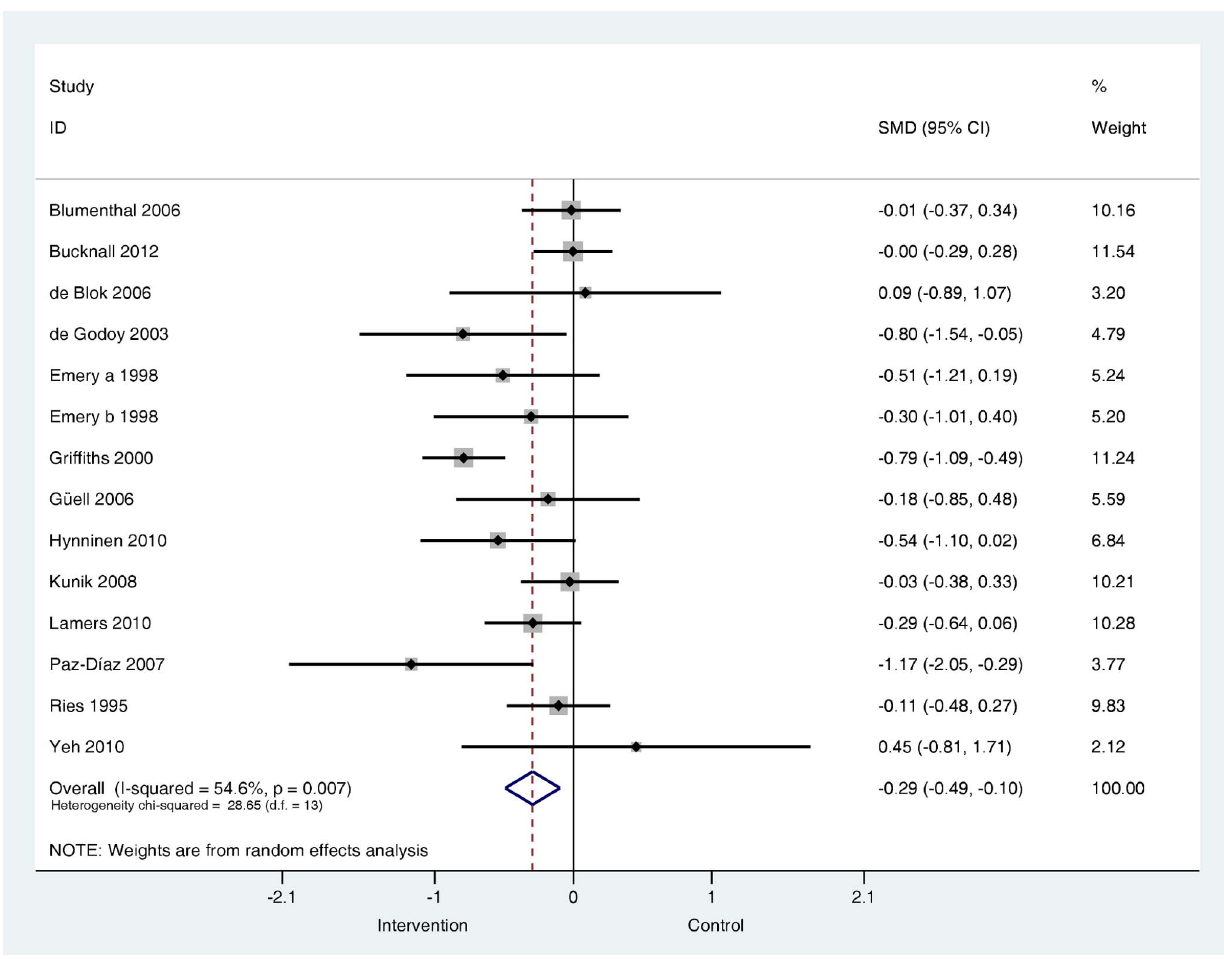
Figure 10. Effects on self-reported symptoms of depression in trials that included confirmed depressed samples or above threshold samples. Note: Random effects model used. 95% CI=95% confidence intervals; SMD=standardised mean difference.